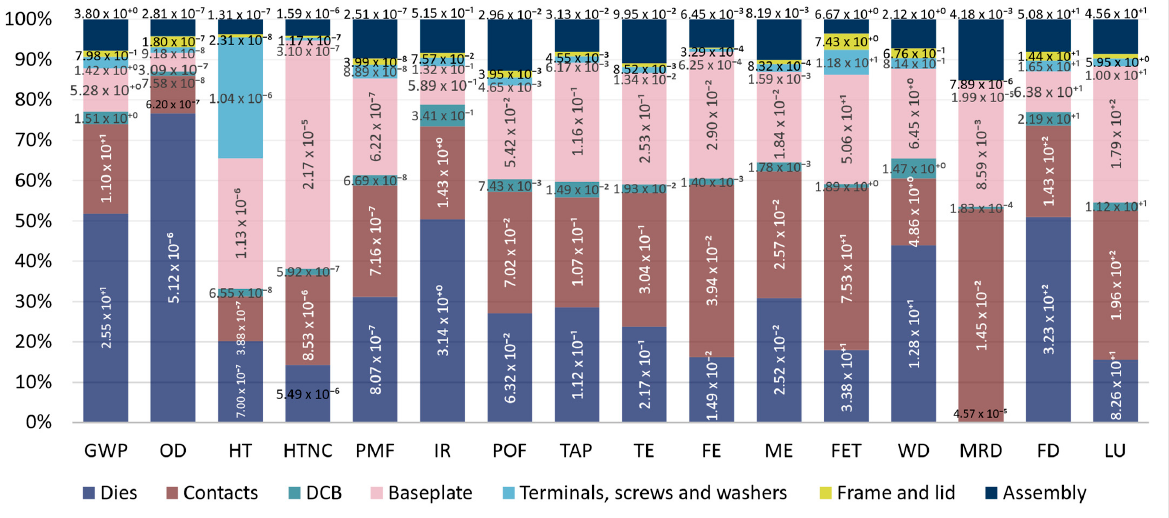
Figure 7. Standardized environmental impacts of the manufacturing phase, “gate-to-gate,” of the 7 subparts of an IGBT power module (150 kW), in adopting the European Commission recommenda- tions for choosing impact categories [27]. Abbreviations are presented in Table 1.